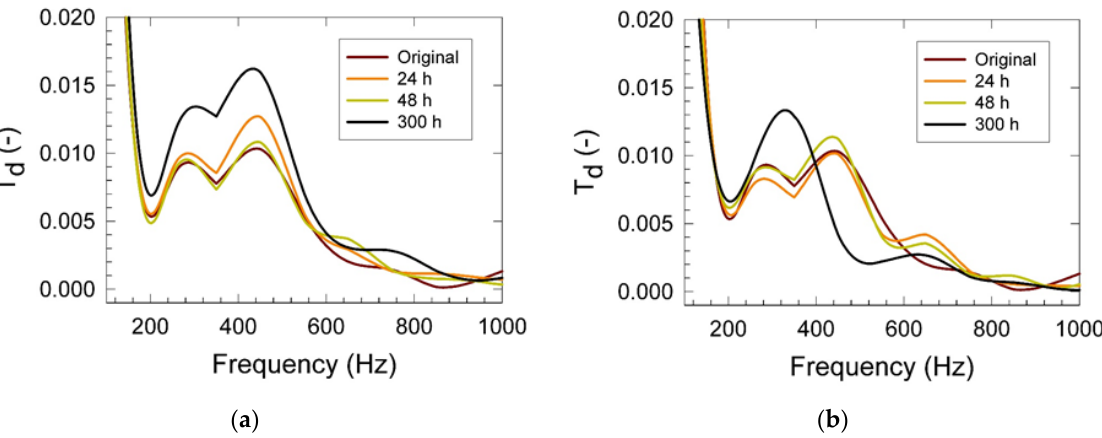
Figure 4. Displacement transmissibility vs. frequency as obtained from the vibration damping measurements of the studied PU materials: ( a ) Effect of the conditioning time at 45 °C and 80% RH; ( b ) Effect of the conditioning time at 80 °C and 80% RH. Inset: Conditioning time (hours), Original — non-conditioned sample.